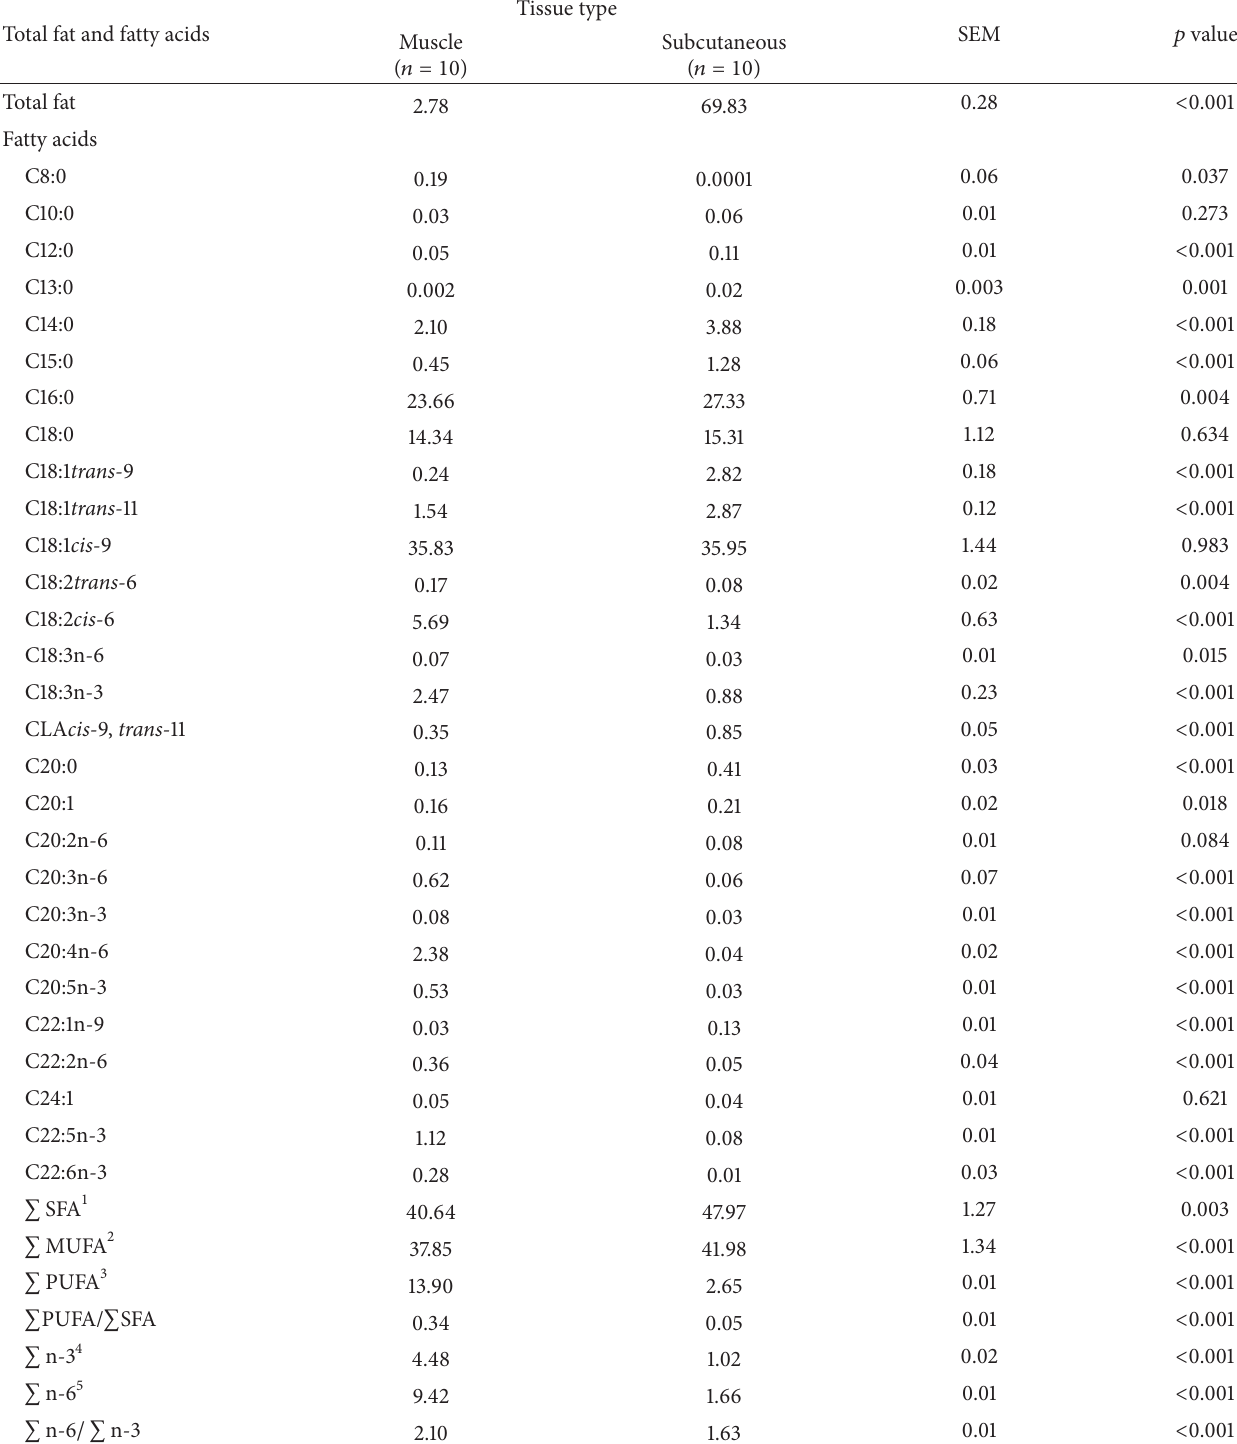
Tissue type SEM 𝑝 value Muscle Subcutaneous ( 𝑛 = 10 ) ( 𝑛 = 10 )